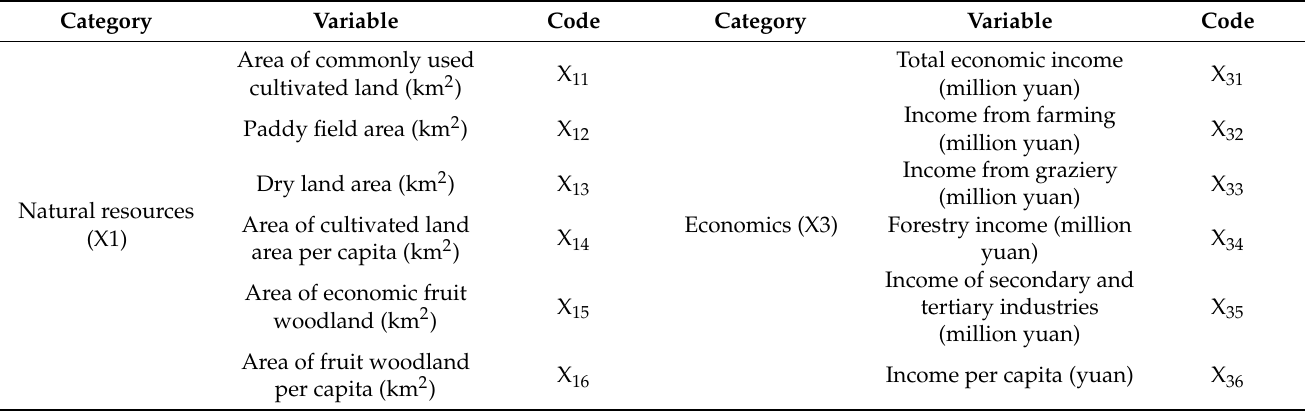
Table 1. Socio-economic data index of